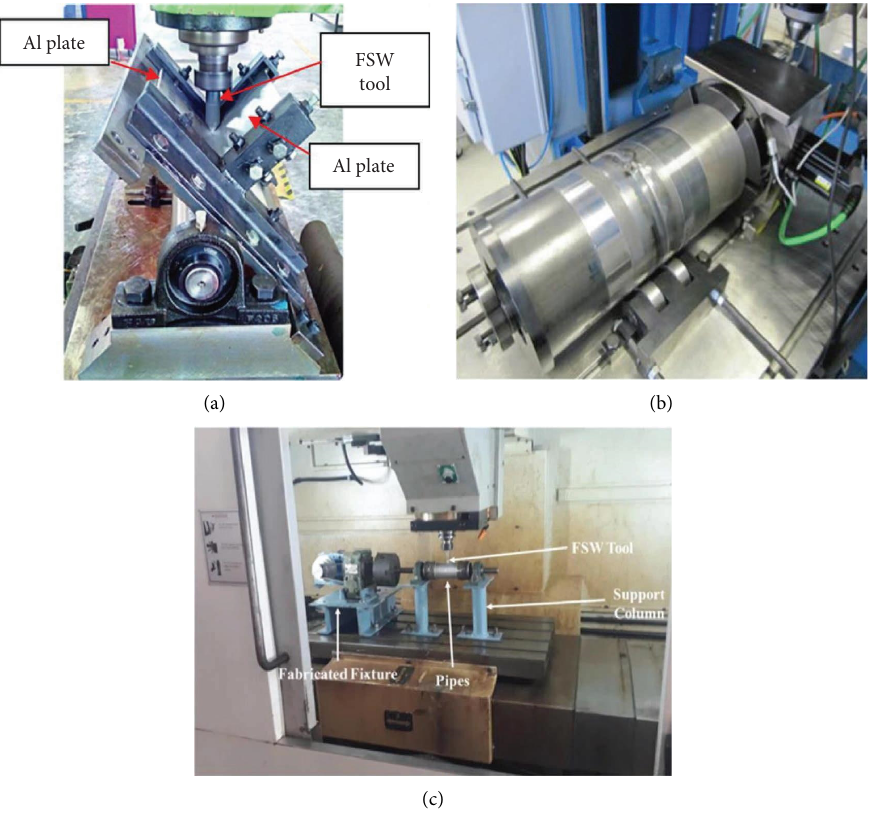
Figure 6: Fixture set up used to produce the FSW joints; (a) T-joint [91], (b) circular geometry [92], and (c) a typical rotary fxture for FSW of pipes